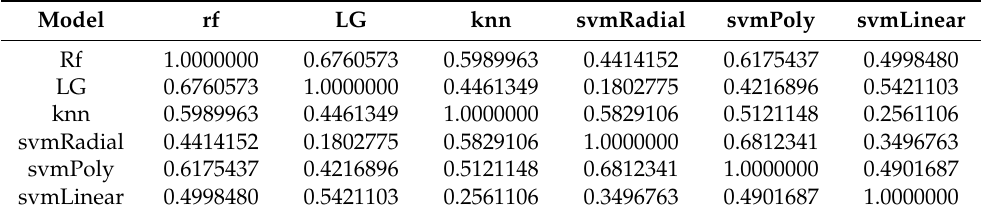
Table 5. The pairwise correlation coefficients for the sub-models in the stacking ensemble.